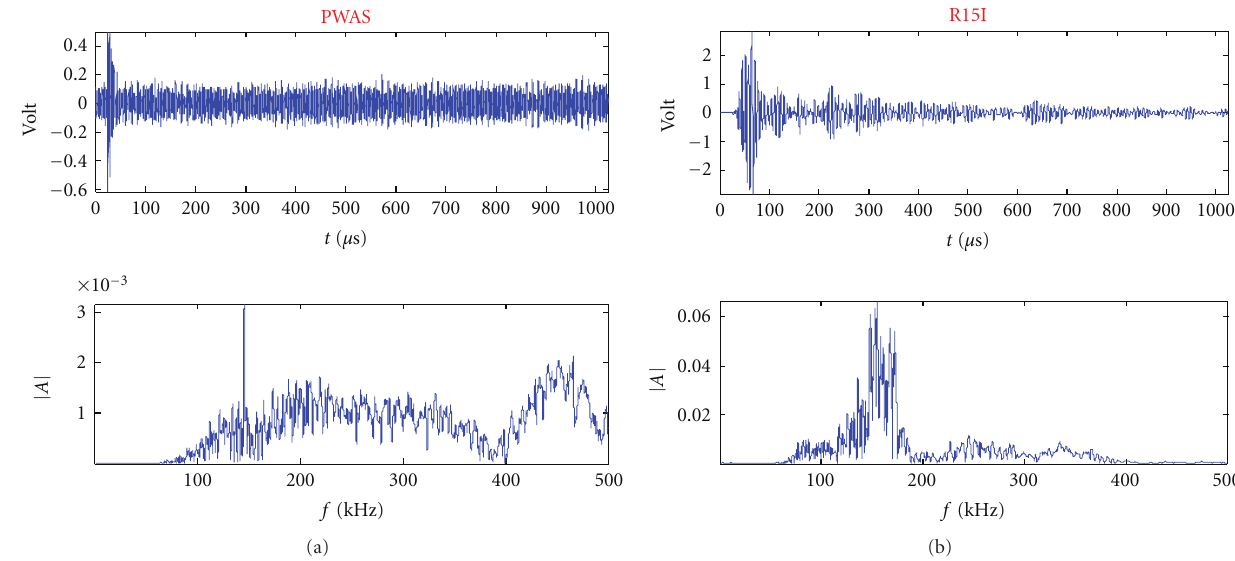
Figure 6: 0.5mm PLB detection on 19-mm steel plate. (a) PWAS AE waveform and its frequency spectrum; (a) R15I AE waveform and its frequency spectrum.